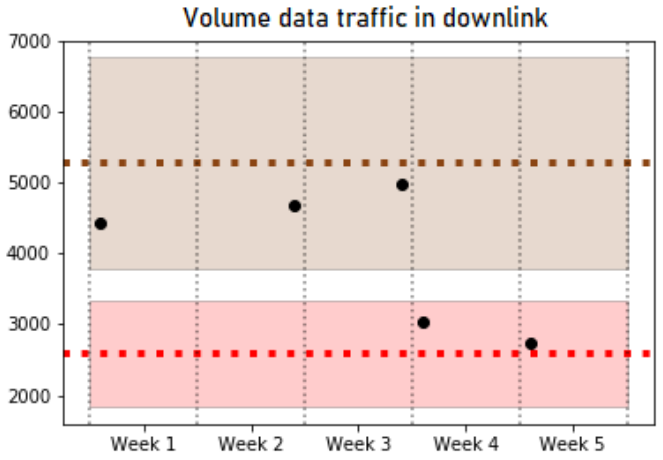
Figure 6. Volume data traffic in downlink.